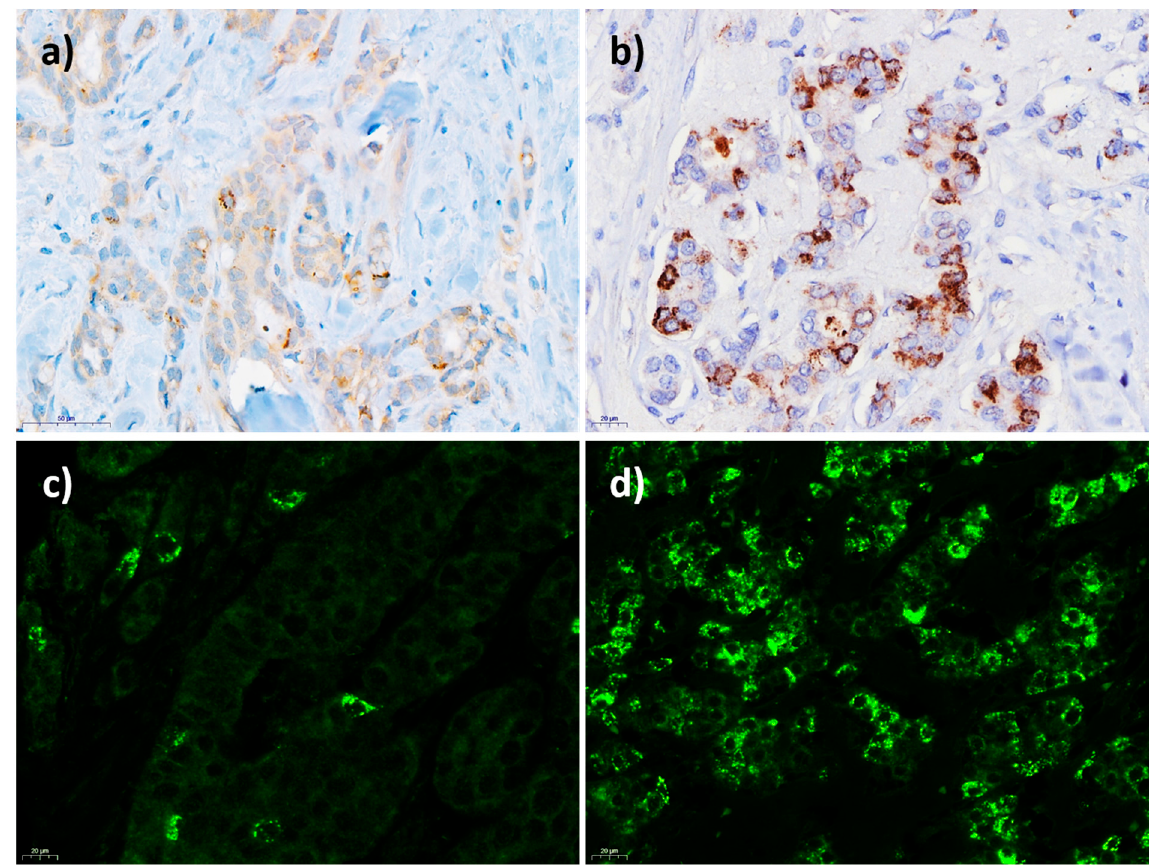
Figure 2. ( a , b ) GD2 immunohistochemistry (IHC) in breast cancer: ( a ) weak to intermediate GD2 positivity in few breast cancer cells; ( b ) intermediate to strong GD2 positivity. ( c , d ) GD2 immunofluorescence (IF) in breast cancer: ( c ) intermediate to strong GD2 positivity in a few breast cancer cells; ( d ) GD2 positivity in more than 50%.